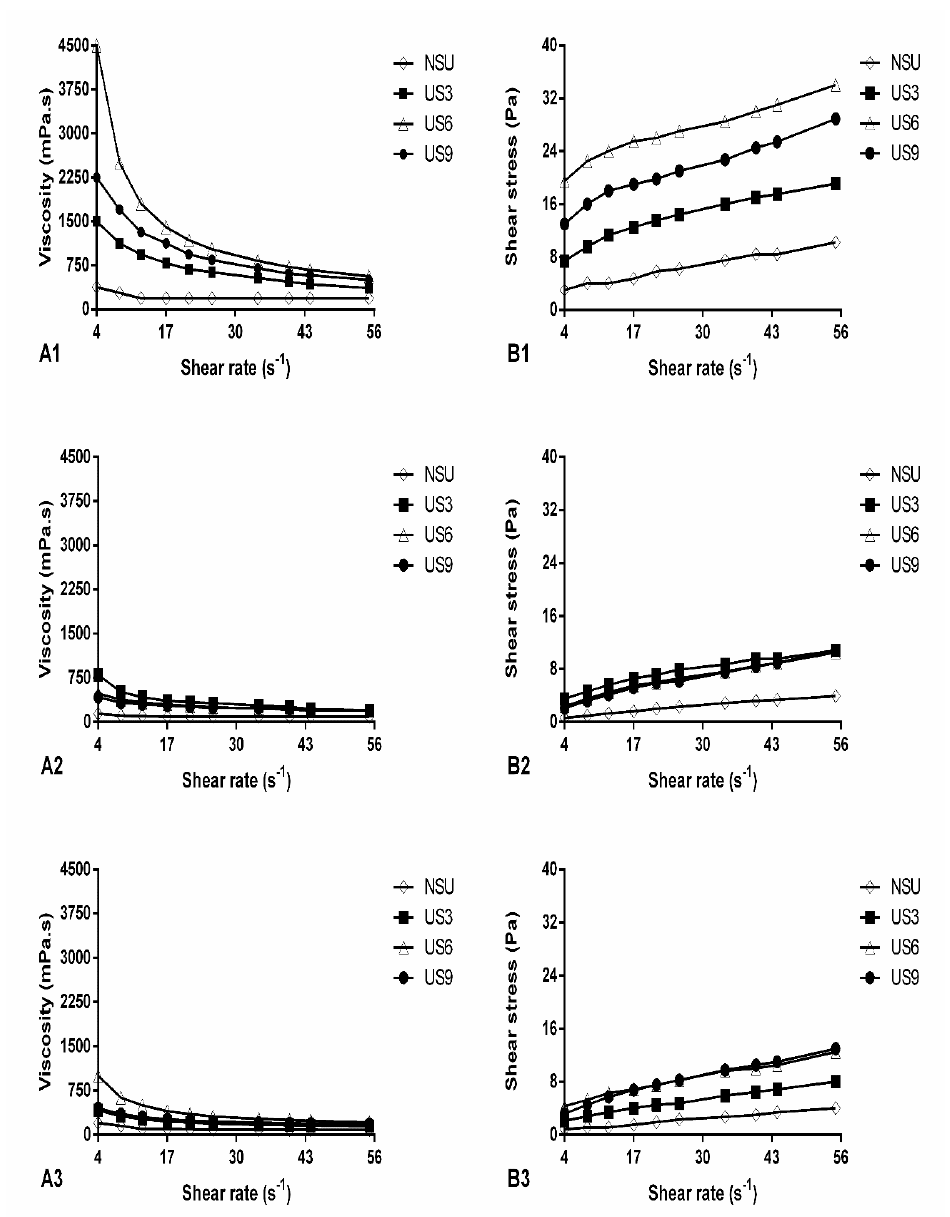
Figure 3. Flow behavior of goat milk yogurt samples during storage time at 4 °C. ( A1 – A3 ) apparent viscosity vs. shear rate; ( B1 – B3 ) Flow curves; ( A1 , B1 ) day 1 of storage; ( A2 , B2 ) day 14 of storage; ( A3 , B3 ) day 28 of storage. NSU, non-ultrasonicated goat milk yogurt; US3, goat milk yogurt sonicated for 3 min; US6, goat milk yogurt sonicated for 6 min; US9, goat milk yogurt sonicated for 9 min.